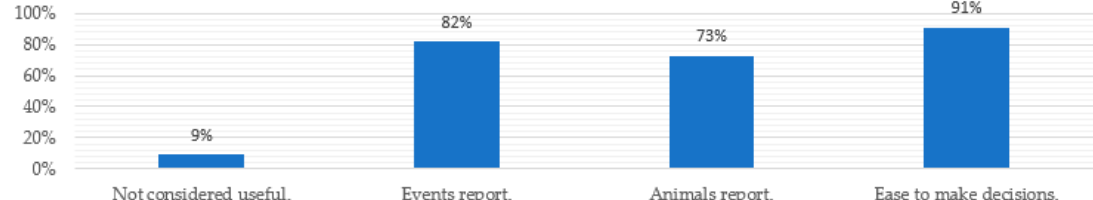
Figure 9. Reasons for using the DSS and considering it useful